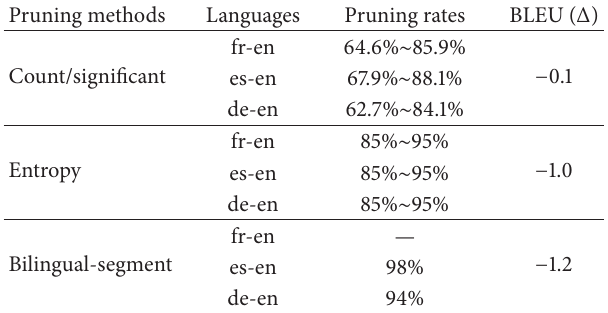
Table 2: Pruned phrase table and translation